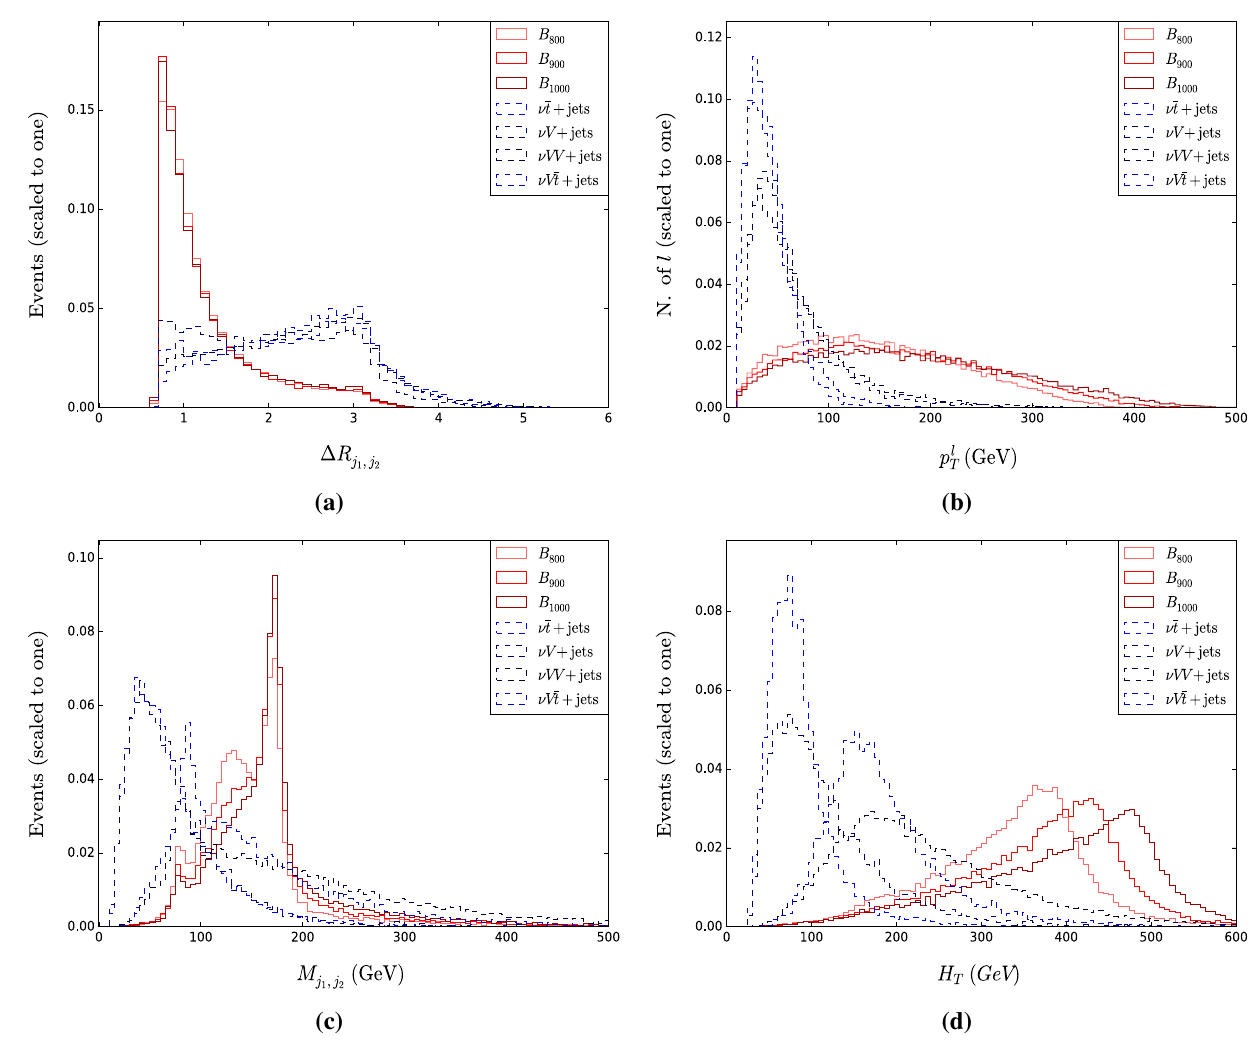
Fig. 9 Normalized distributions of (cid:12) R fb −